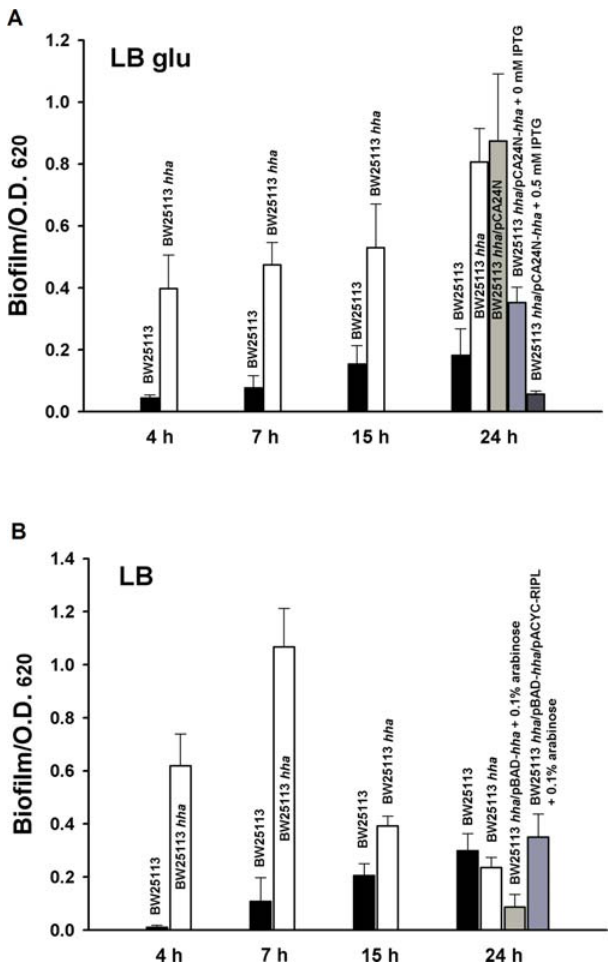
Figure 1. Hha decreases total biofilm formation. Biofilm formation normalized by cell growth shown after 4 h, 7 h, 15 h, and 24 h at 37 u C for the wild-type BW25113 and BW25113 hha in (A) LB glu and (B) LB medium. Complementation of biofilm formation is indicated in LB glu using pCA24N- hha (A), and in LB using pACYC-RIPL to express rare codons (B). Each experiment was performed in triplicate, and one standard deviation is shown.